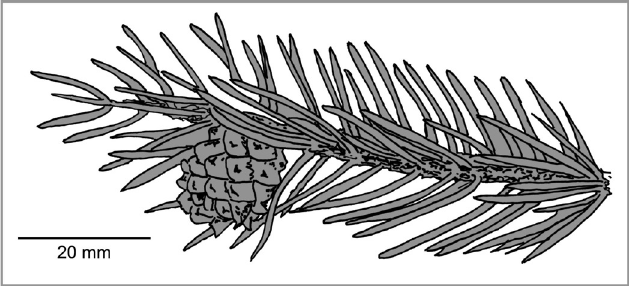
Fig. 5. Adelges (Aphrastasia) pectinatae (Cholodkovsky, 1888). Gall on Picea abies (after Cholodkovsky, redrawn and modified from Shaposhnikov